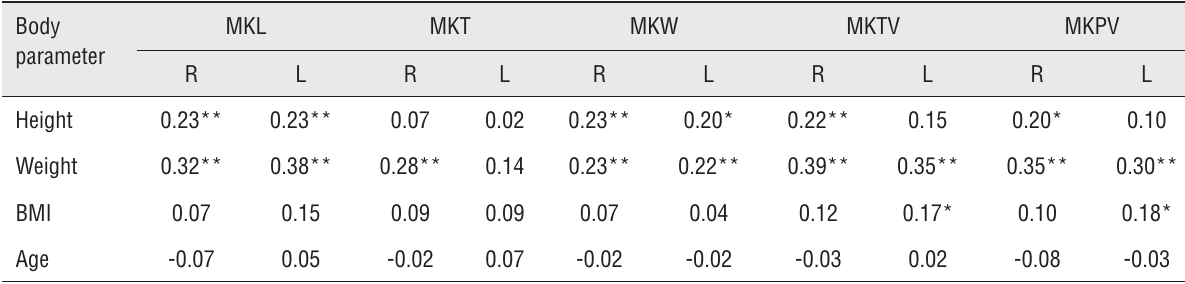
Table 3 - Correlation between patients’ kidney dimensions and body parameters. Body parameter